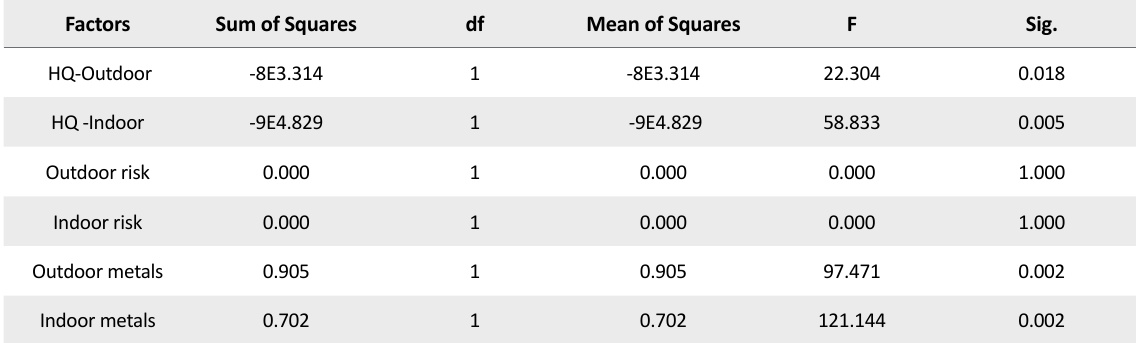
Table 5. Comparing MANOVA results between indoor/outdoor environments in high-traffic areas of Tehran Metropolis, Winter 2018 Factors Sum of Squares